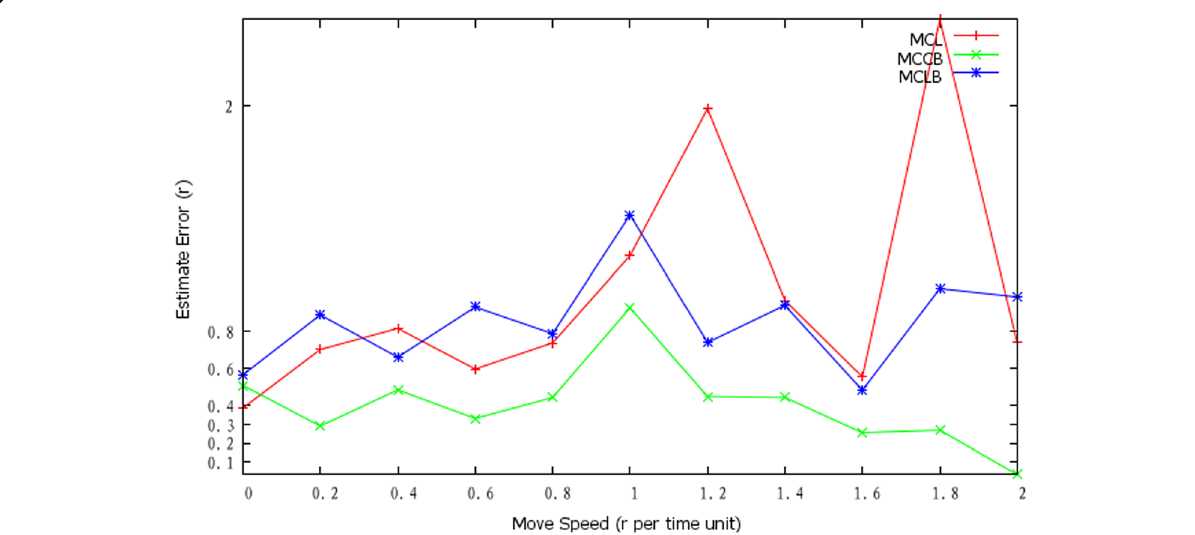
Fig. 3 Anchor nodes by 100-m intervals comparison chart. From the top anchor node, the spacing was 100 m, chart to see when a node moving speed changes from 0 m to 100 m accuracy of CMCL positioning is the best; when you can see the positioning accuracy is approximately 100 m about 50%; when the accuracy of 30%; and 25 m accuracy when completely in 17% or